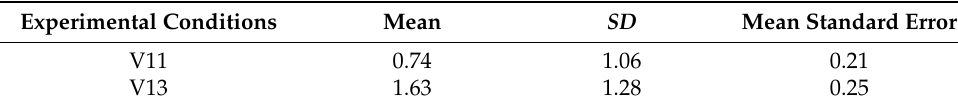
Table 8. Errors made in the maze experiment.